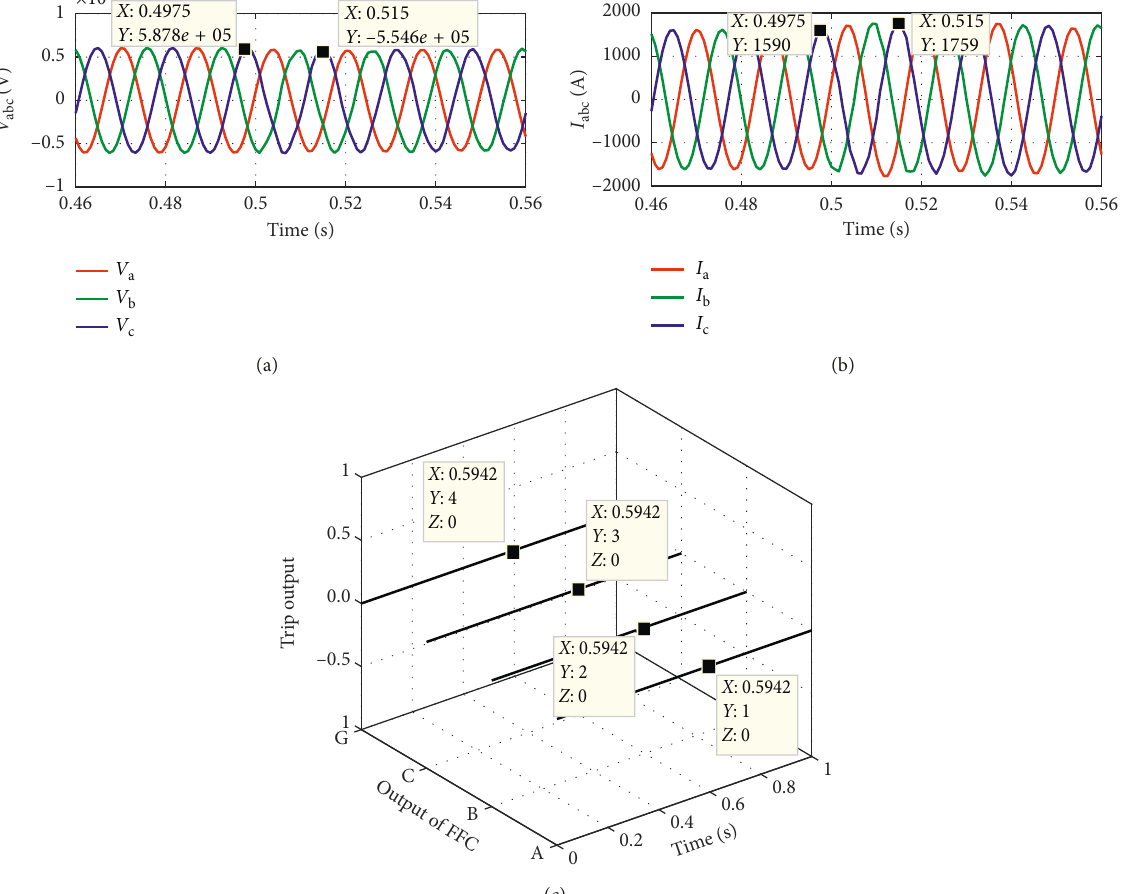
1000MW, and Q 800MVAr: (a) 3-phase voltage waveform; (b) 3- (cid:31) (cid:31)